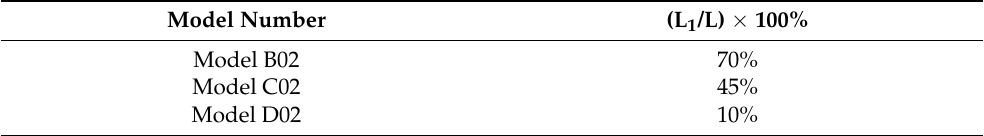
Figure 4. Longitudinal position.